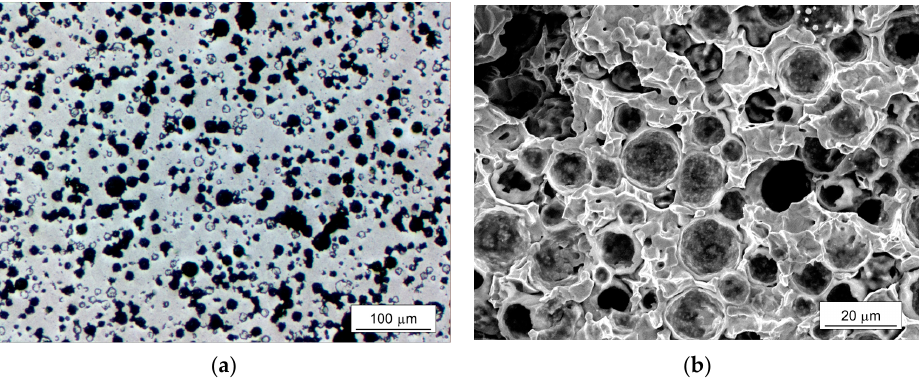
Figure 1. ( a ) Optical microscope image of the microstructure; ( b ) scanning electron microscope image of a freeze-fractured cross section of the iron syntactic foam with 5 wt % hollow glass